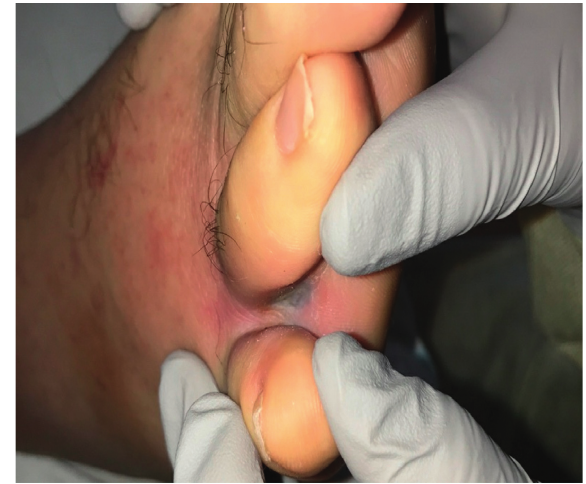
Figure 4: Fusarium infection presenting as a skin ulceration in his toes.